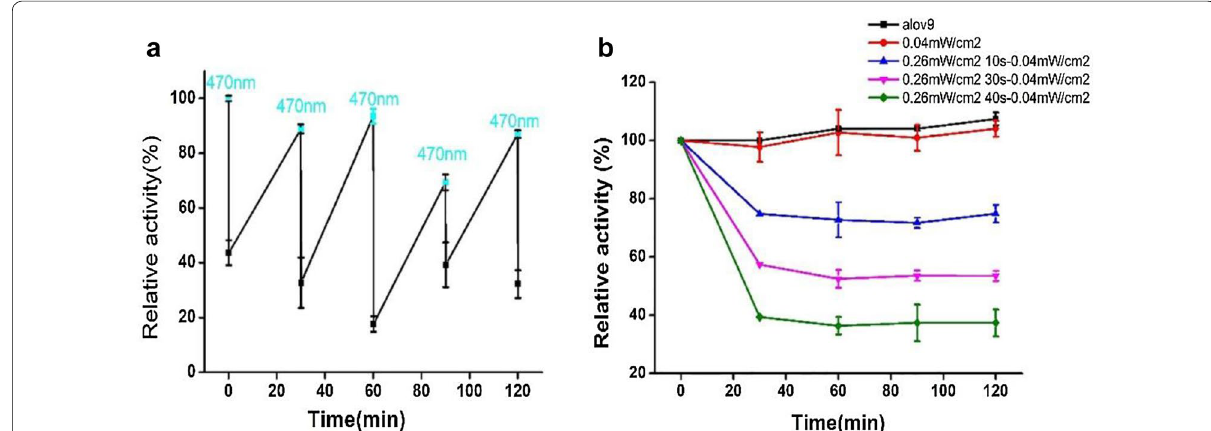
Fig. 4 Reversible photocontrol of alov9 activity. a The activity of alov9 will decrease rapidly in a short time under the irradiation of 470 nm blue light. Then the enzyme activity will slowly recover in the dark state. b The activity of alov9 will rapidly decrease with a strong irradiation. We keep lighting with weak intensity, and alov9 activity does not recover but remains at a certain level. All error bars show SEM ( n